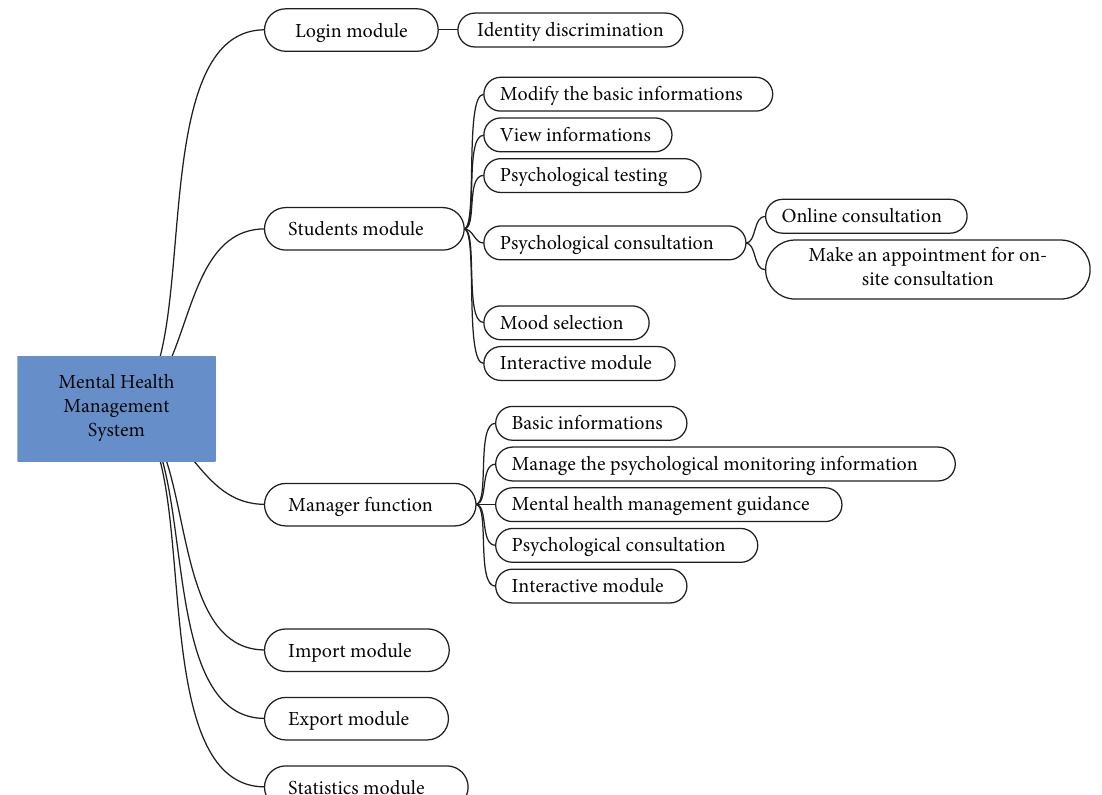
Figure 5: Functional diagram of smart campus mental health management system.